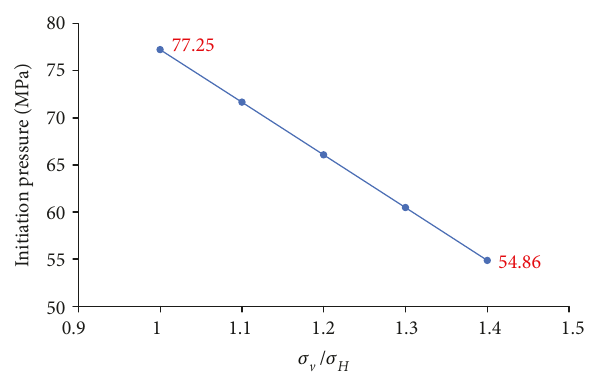
Figure 7: The relationship curve between initiation pressure and σ σ v / H .